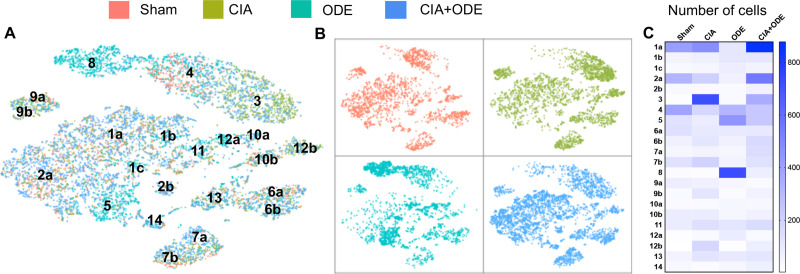
Distribution of aggregated gene clusters among treatment groups.Sham, CIA, ODE and CIA+ODE treatment groups demonstrate differences in cell distribution among 14 gene clusters. Sham is represented by red, CIA by green, ODE by teal, CIA+ODE by blue. (A) tSNE plot with all the treatment groups merged with respective colors (B) Treatment groups are plotted individually with their respective colors to show cell distribution. (C) Heatmap shows number of cells per sub-cluster among treatment groups by manual sub-clustering (total cells = 11,577).